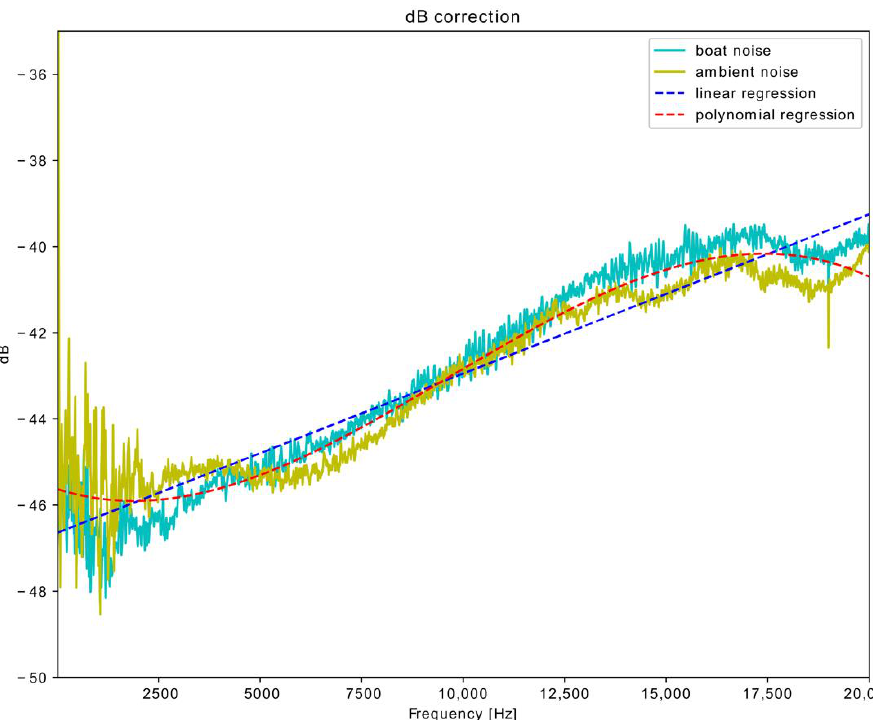
Figure 9. Plot of the corrections to be applied to the spectrum of the data from the low-cost system in the two cases: boat noise (cyan), ambient noise (green), a linear regression (blue), and polynomial regression (red) are identified and applied automatically to the recordings.